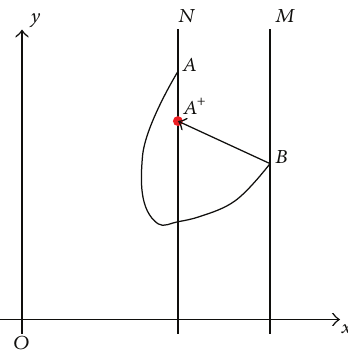
Figure 1: Illustration of the successor function.